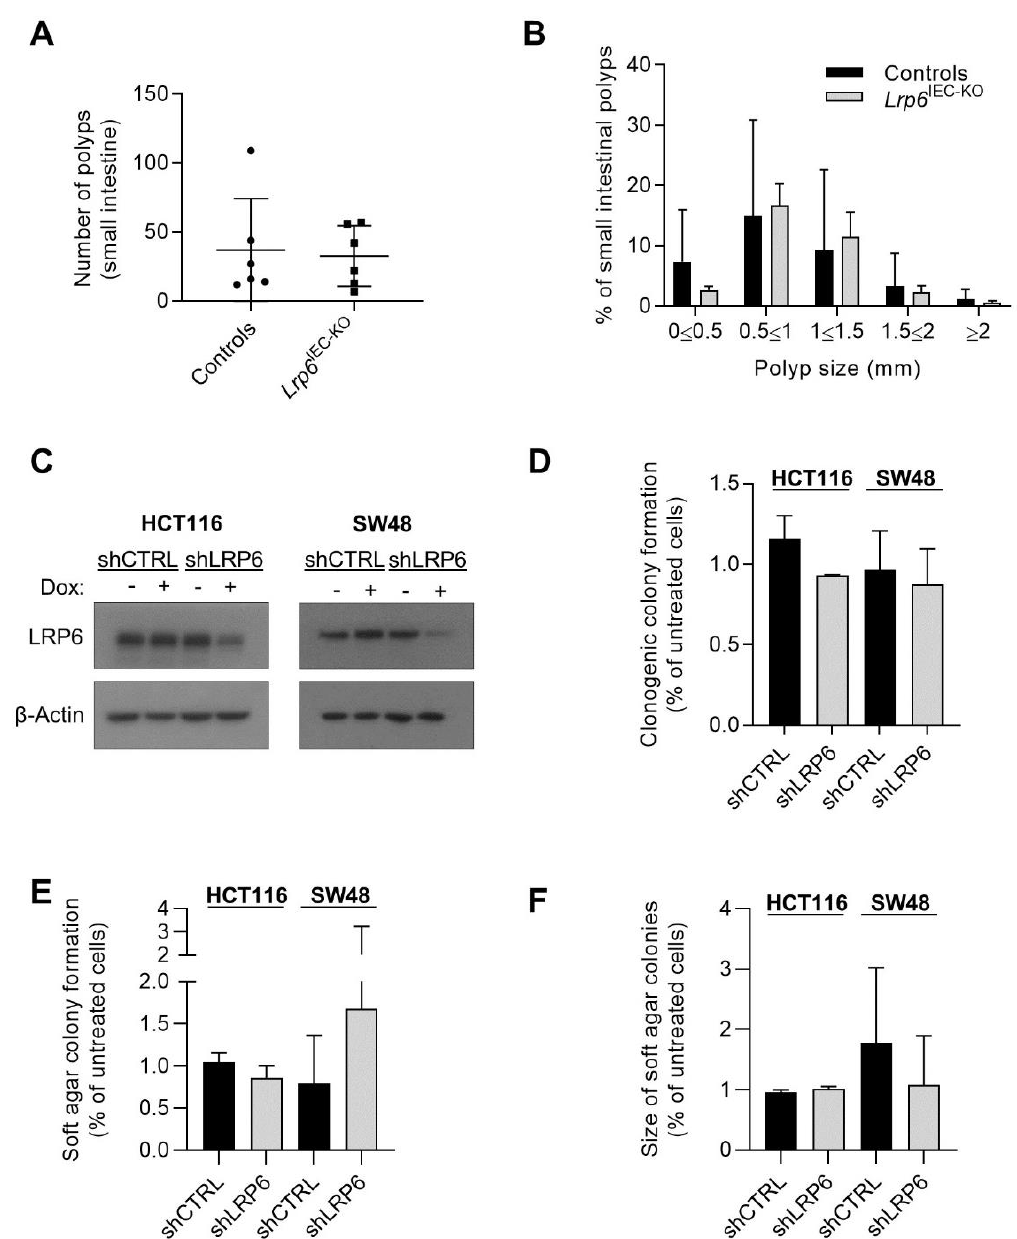
Figure 4. Role of LRP6 in adenoma formation and growth of colorectal cancer cells. ( A ) Polyp number was counted in 12-week-old Lrp6 loxP/loxP ; Villin -Cre; Apc Min/+ small intestines compared to controls ( Lrp6 loxP/+ ; Apc Min/+ or Lrp6 loxP/loxP ; Apc Min/+ ) ( n ≥ 5). ( B ) Small intestinal polyp size (diameter) was analyzed in Lrp6 loxP/loxP ; Villin -Cre; Apc Min/+ and control mice ( n ≥ 5). ( C )